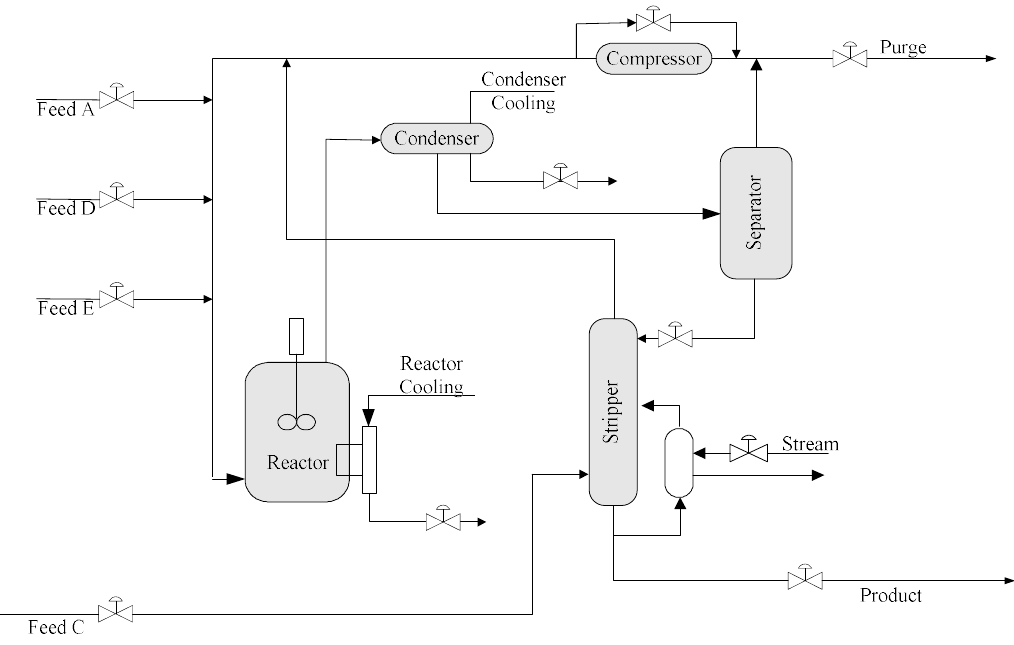
Figure 2. Simplified diagram of the Tennessee Eastman (TE)